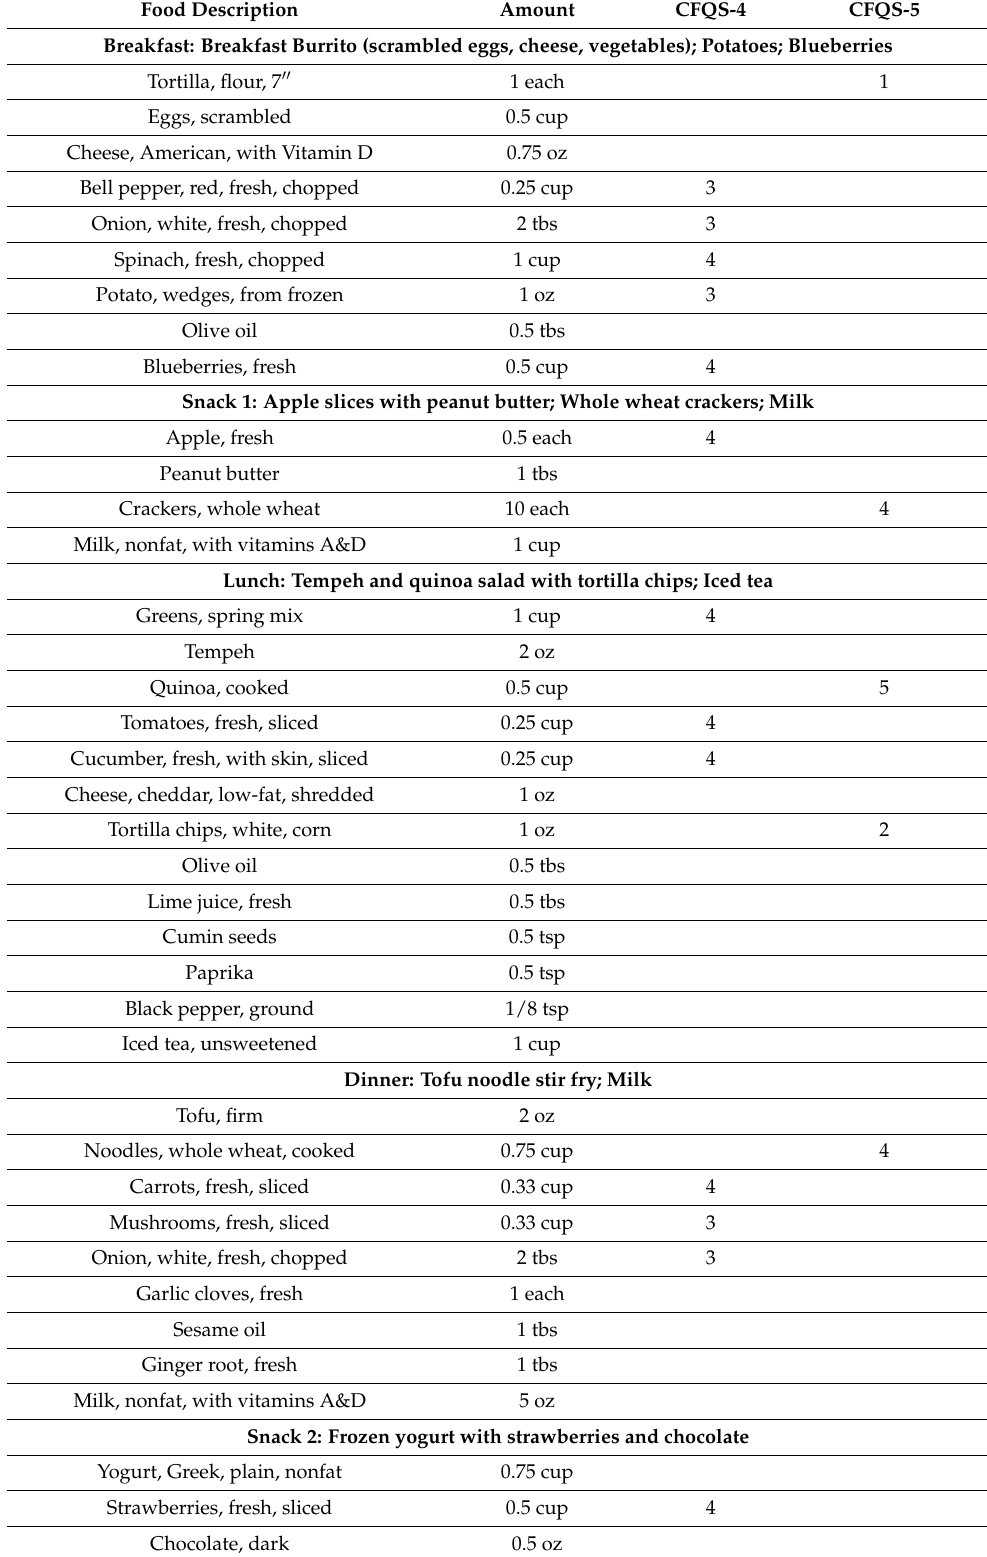
Table 7. Sample Daily Menu: Healthy